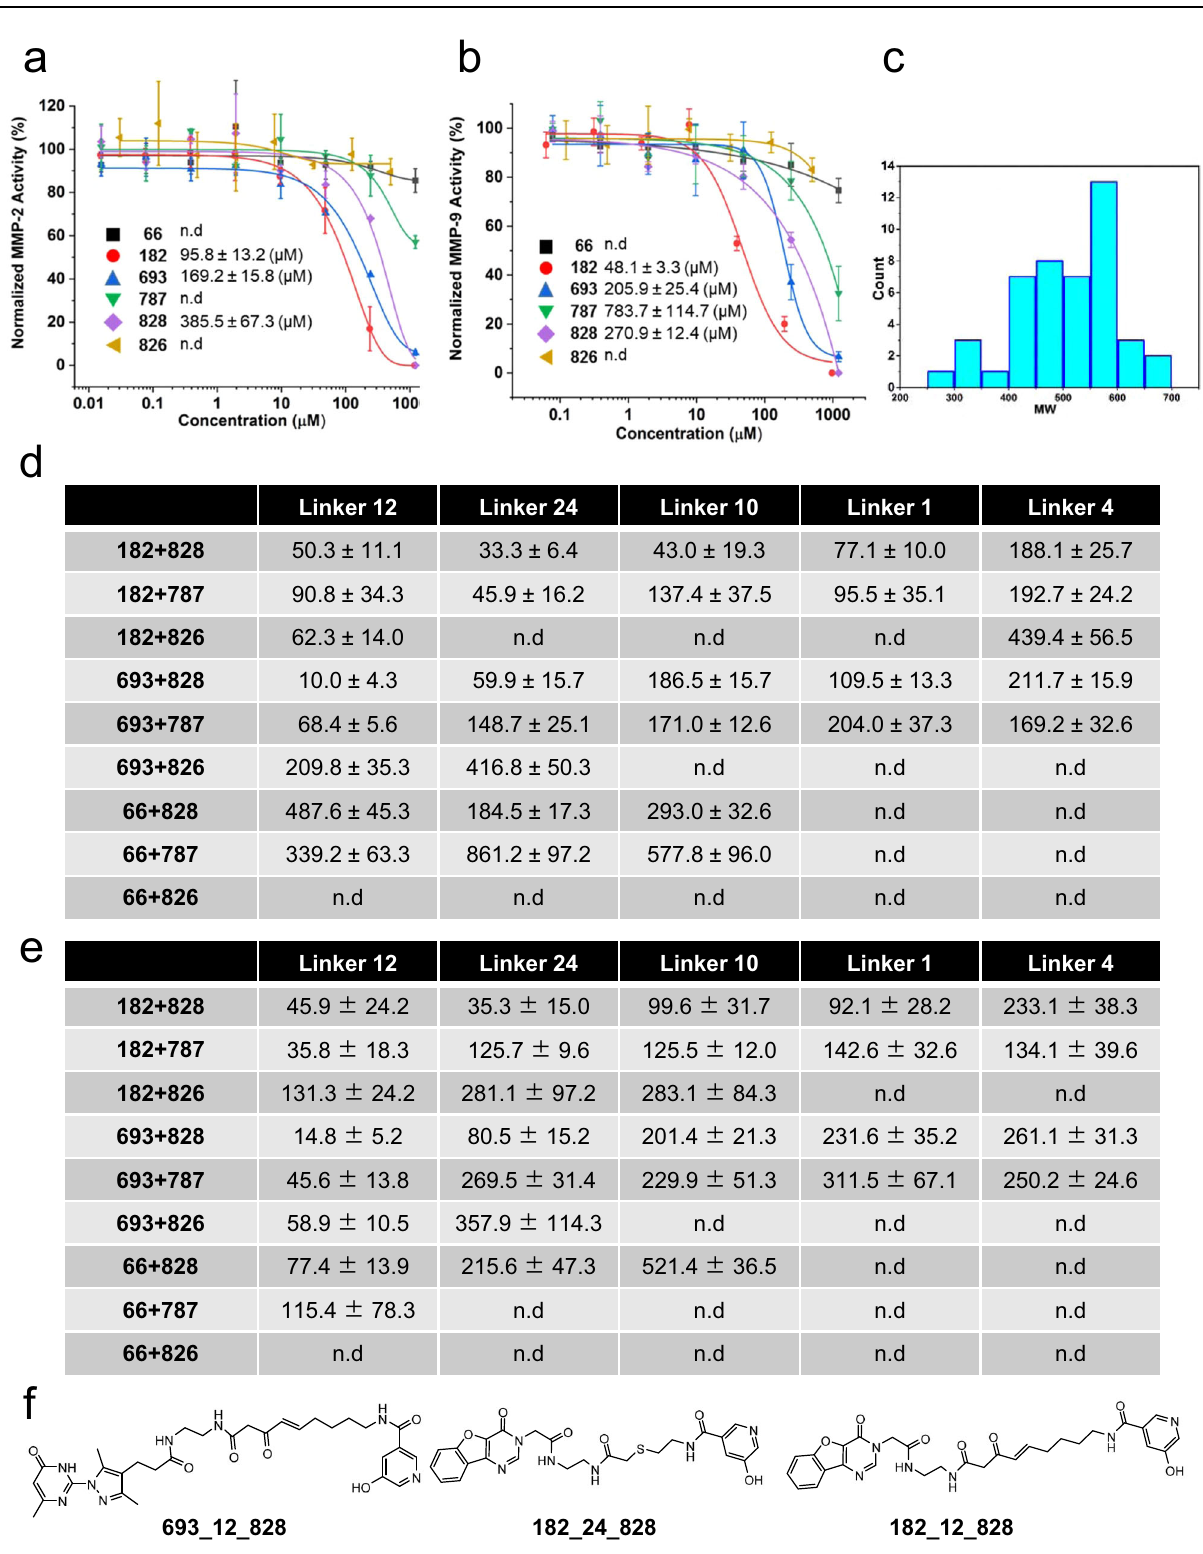
errorbarrepresents the standarderrorof the calculated IC 50 . The compoundsare grouped by nine fragment combinations. Each group contains fi ve compounds differing by the linker moieties selected from SL-B. Data are presented as mean values±SE. n.d: not detected f The structure of compounds with the best inhibi- tory effect out of the 45 small molecules. Source data are provided as a Source Data fi